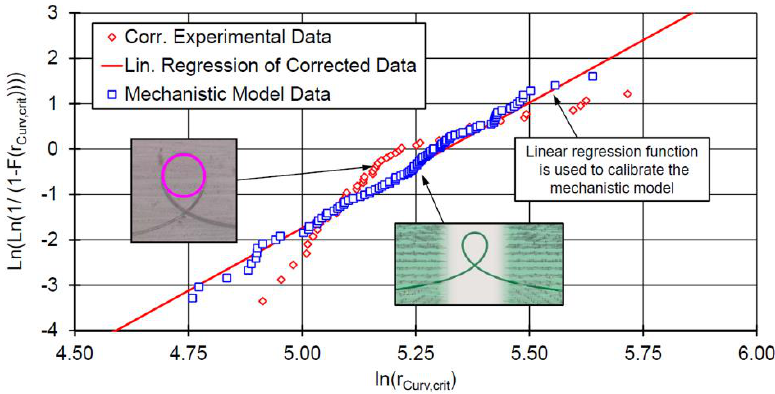
Figure 12. Calibration and validation of fiber breakage model and experiment [28].